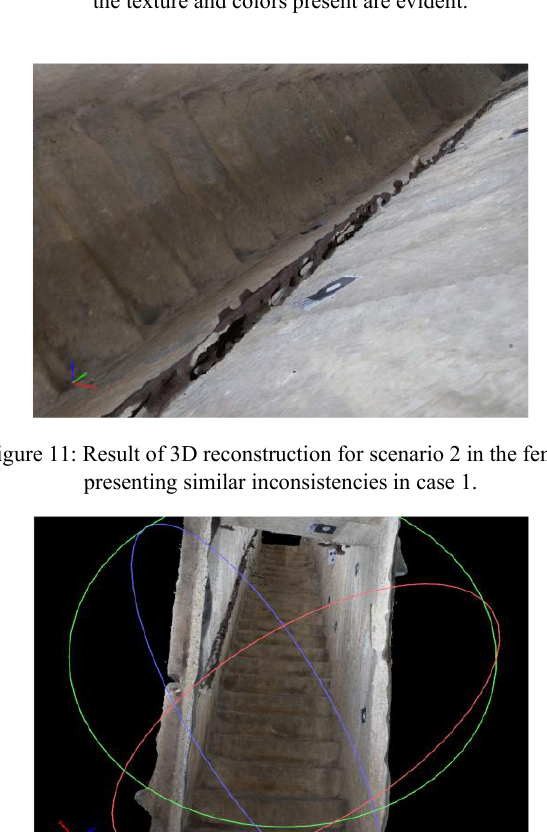
Figure 10: 3D Reconstruction result for case 2. Inconsistencies in the texture and colors present are evident.